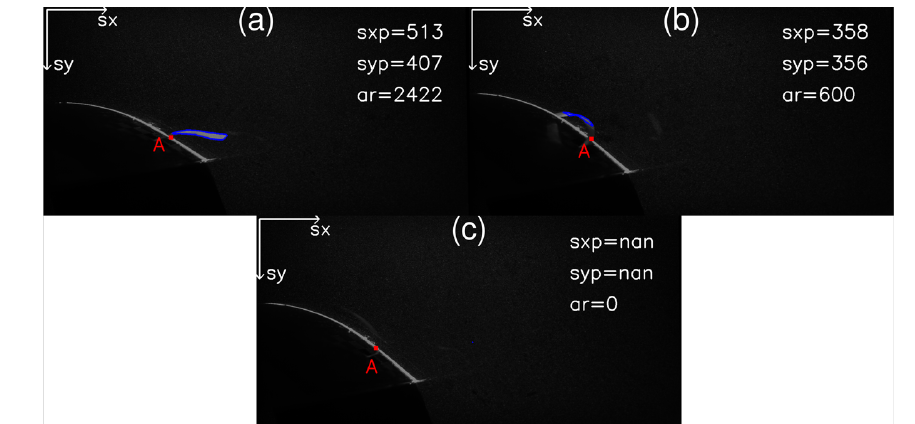
Figure 4. Detected strip contour from PIV images using OpenCV: (a) for the attached flow case and (b) for the detached flow case (c) corresponding to an outlier case (impossible to detect the strip position). sxp and syp are respectively the streamwise and spanwise positions in pixels of the center of the detected area (in blue). ar is the area of the detected contour in pixels. The e-TellTale sensor is attached to the wall in